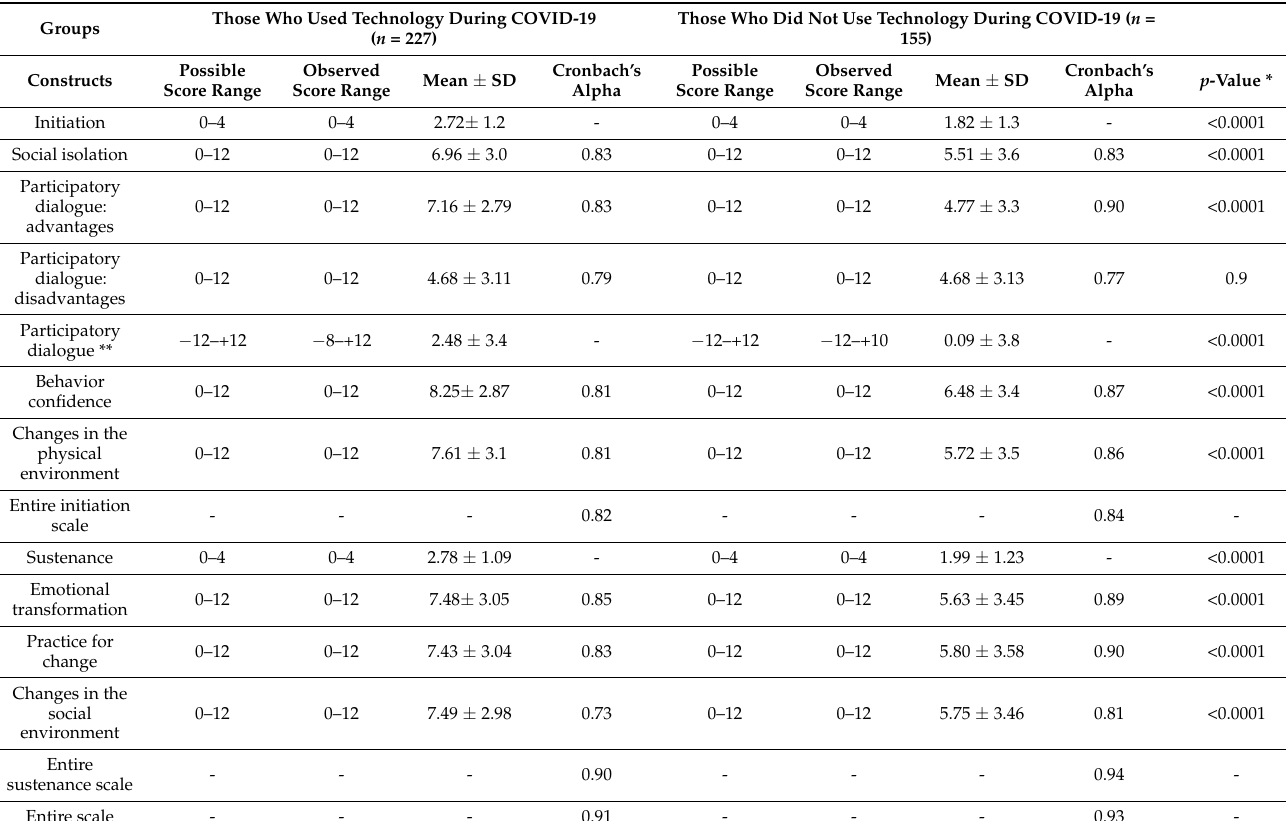
Table 3. Comparing mean scores of MTM constructs and reliability diagnostics across groups.